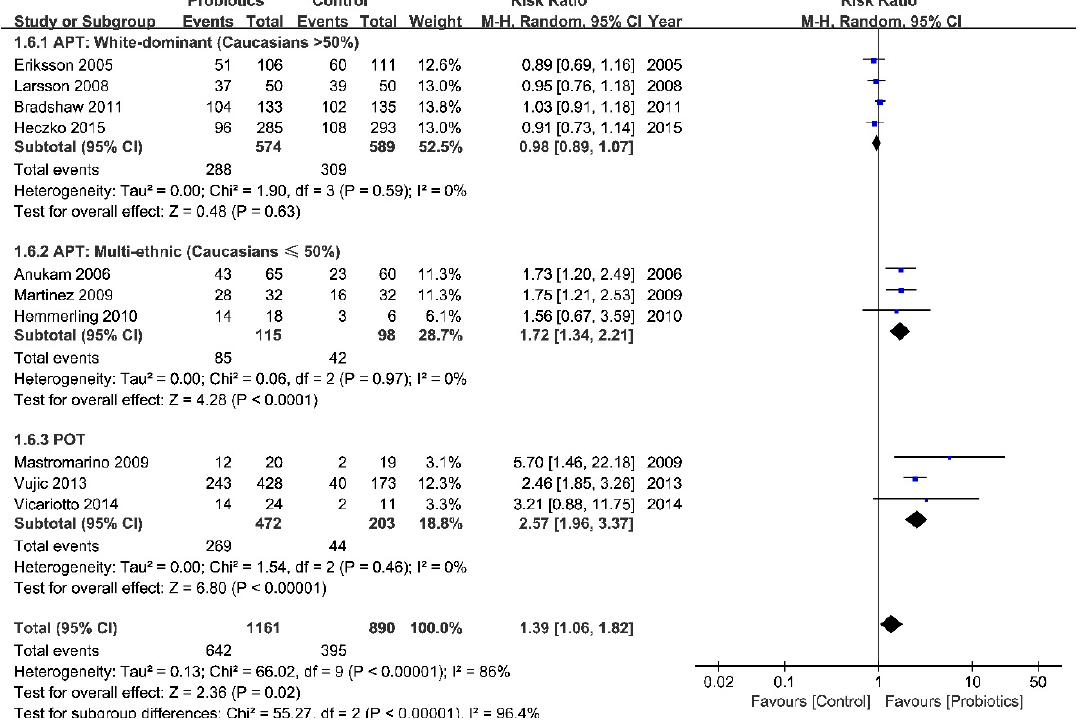
Figure 2. Forest plot: the e ffi cacy of probiotics vs. placebo for BV after a normal menstrual cycle (around the 30th day after intervention, divided by ethnic groups). Abbreviations: APT = antibiotic + probiotic treatment; POT = probiotic only treatment; NA = no data available.